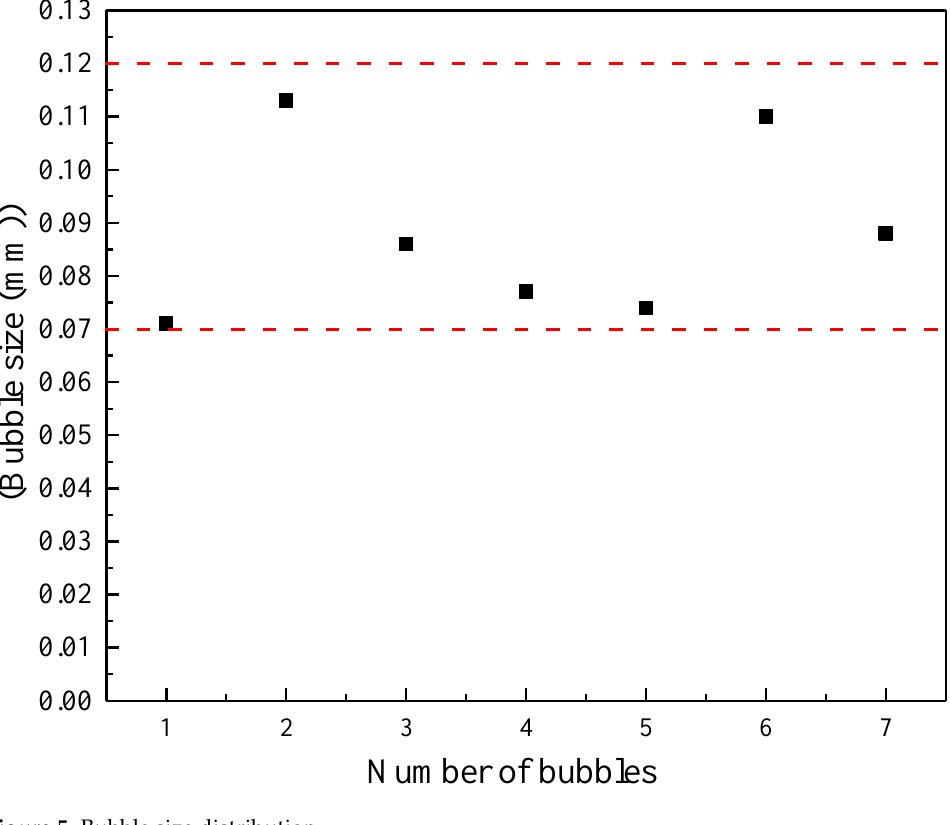
Figure 6. The relationship between the recovery rate and the amount of octyl hydroxamic acid (pH = 10). As can be seen, the recovery significantly achieves an average increase of approxi- mately 7% after being treated with microbubbles. The recovery of fine wolframite with or without microbubbles changed similarly with an increase in the concentration of hydrox- amic acid. The recovery increases sharply with the increase in the concentration of hy- droxamic acid. When the concentration of hydroxamic acid is 150 mg/L, the recovery of